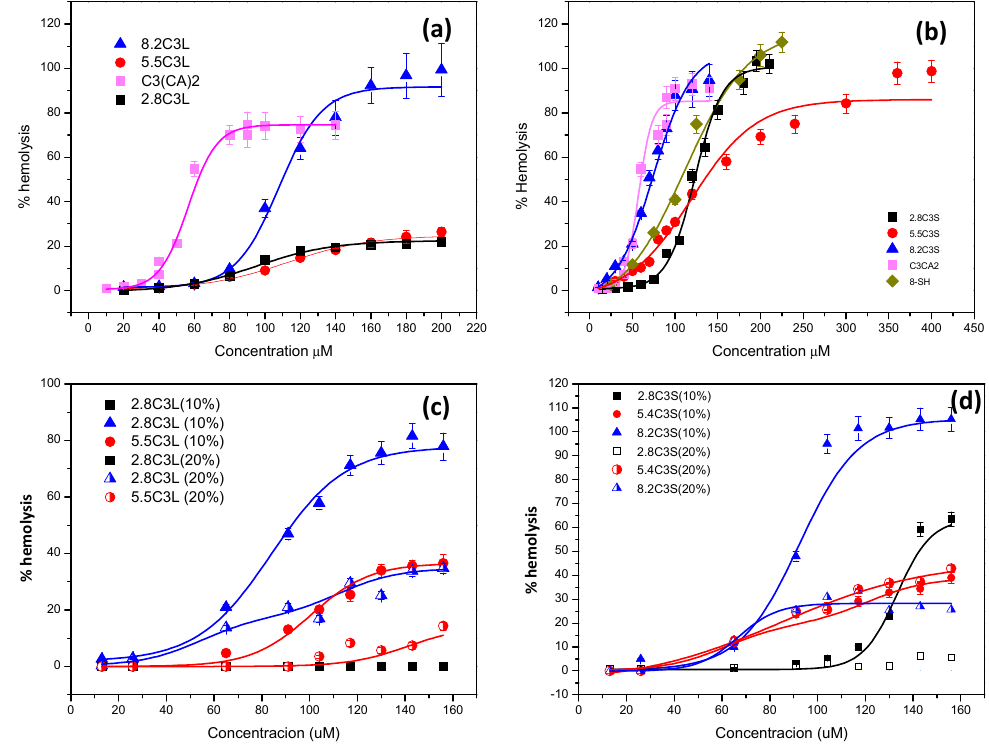
Figure 8. Hemolysis percentage against surfactant concentration for the C3L ( a ) and C3S ( b ) systems and their cholesterol containing mixtures ( c , d ). Table 5. HC 50 values of pure surfactants and their catanionic mixtures.